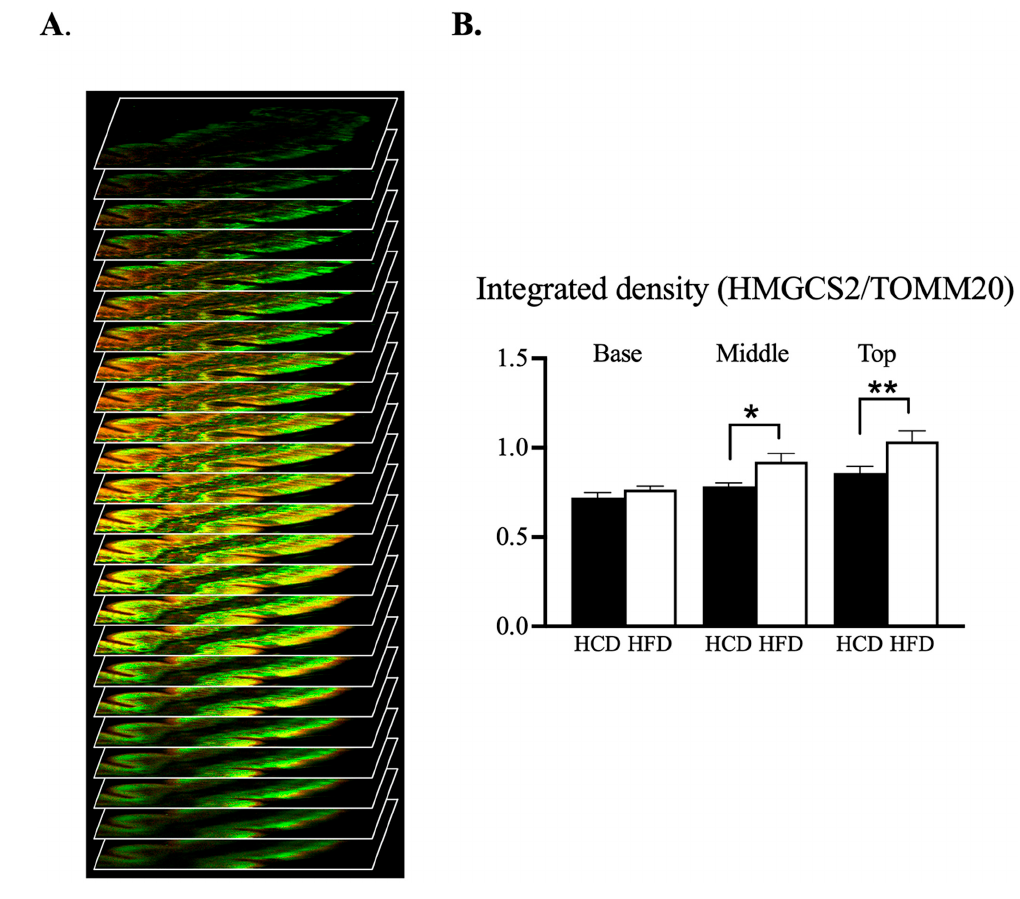
Figure 6. ( A ). Graphical representation of optical sectioning from confocal scanning microscopy of villus. ( B ). Confocal microscopy showing intensity of HMGCS2 per TOMM20 at different locations (base, middle and top) of jejunal villus after 2 weeks of HCD and HFD. Data are given as mean + SEM; n = 9 (number of individuals = 3), 2-way ANOVA with Sidak’s multiple comparison test used for statistical analysis, * p ≤ 0.05, ** p ≤